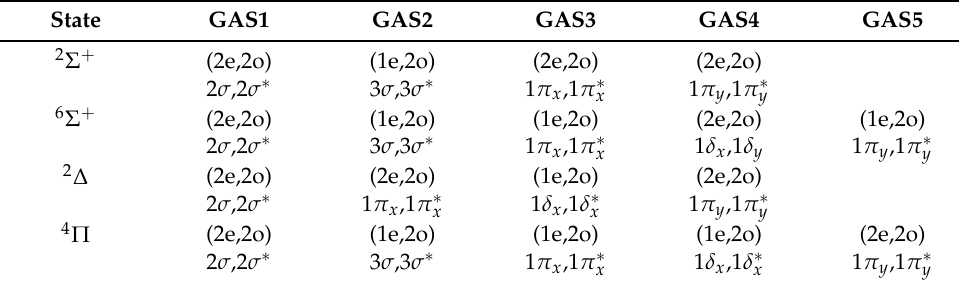
Table 2. The SP approximation subspaces listed by